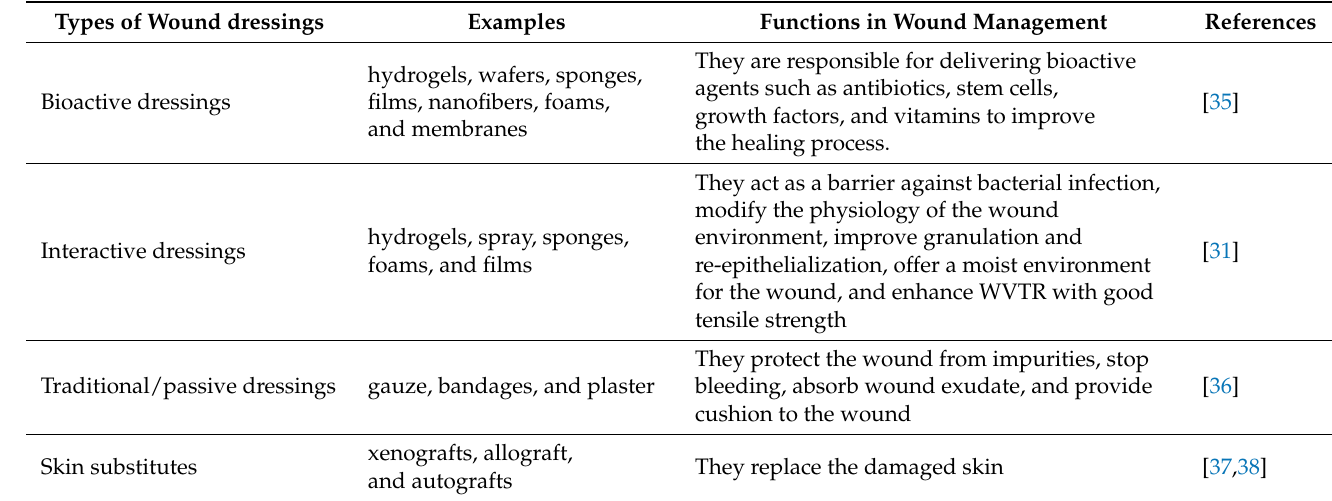
Table 1. Summary of classification of wound dressing materials.